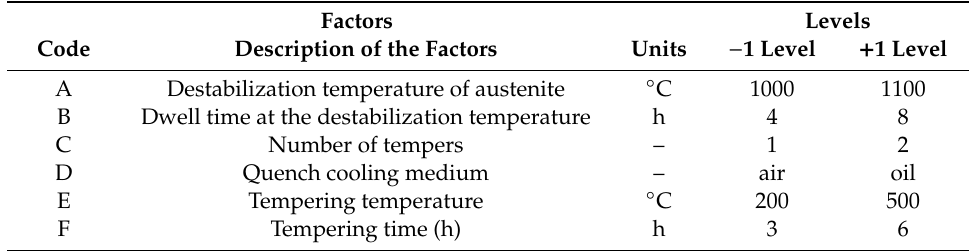
Table 2. Factors and Levels. The factors analysed in the Design of Experiments (DoE) are shown. These factors are denominated using the letters A to F.